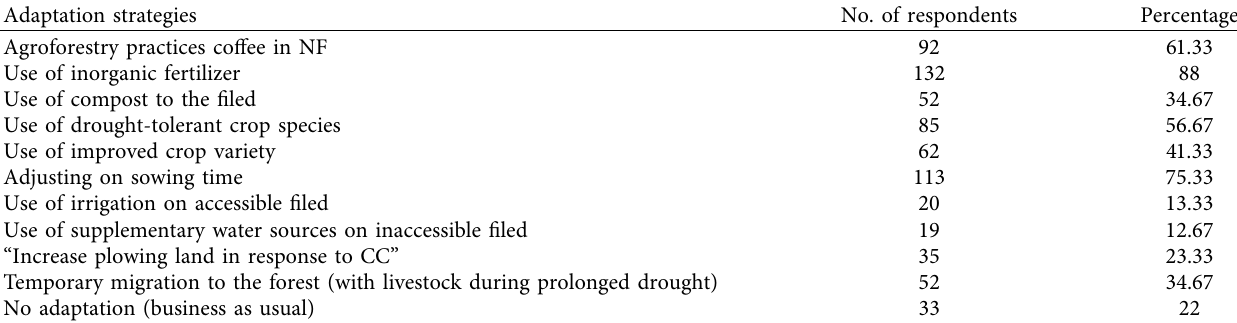
Figure 3: Analysis of annual total, “Belg (spring)” and “Meher (summer)” seasonal rainfall. Source: data from meteorological station data result Table 4: Types of adaptation strategies practiced by the households in the study area.